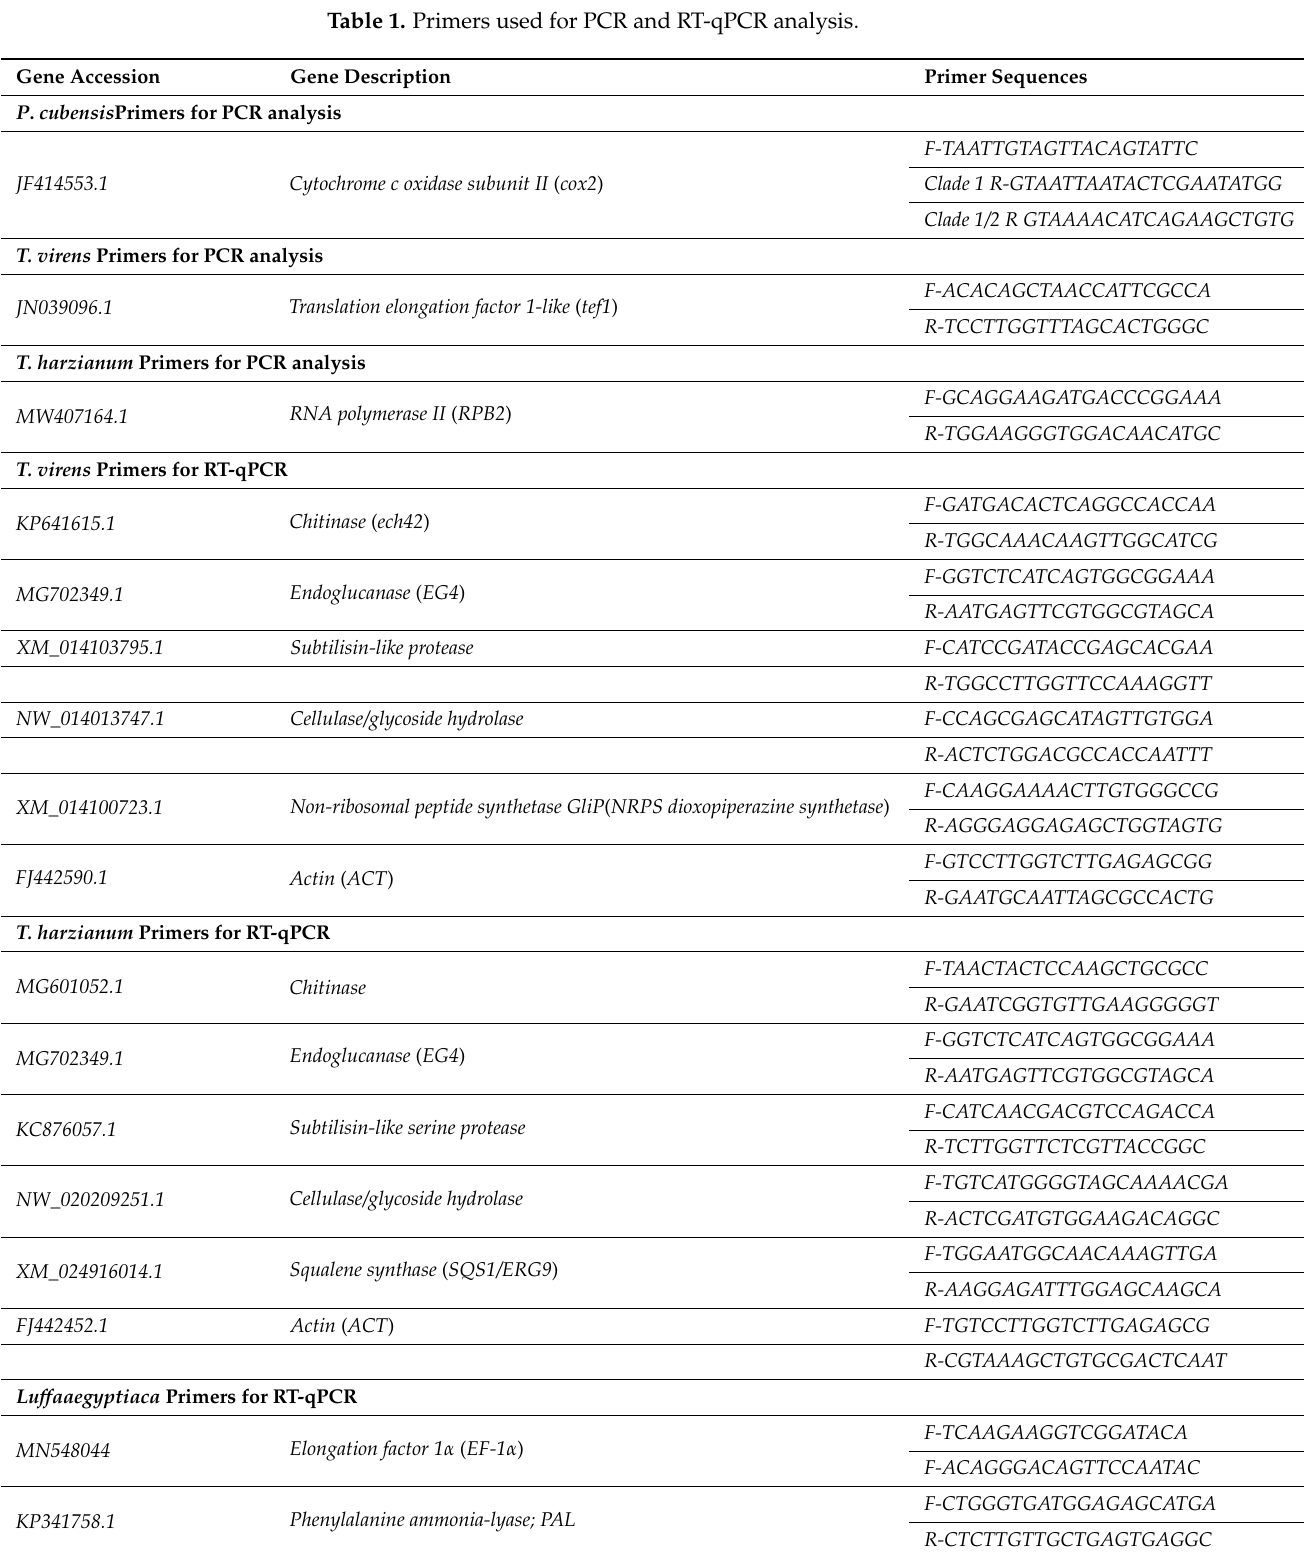
Table 1. Primers used for PCR and RT-qPCR